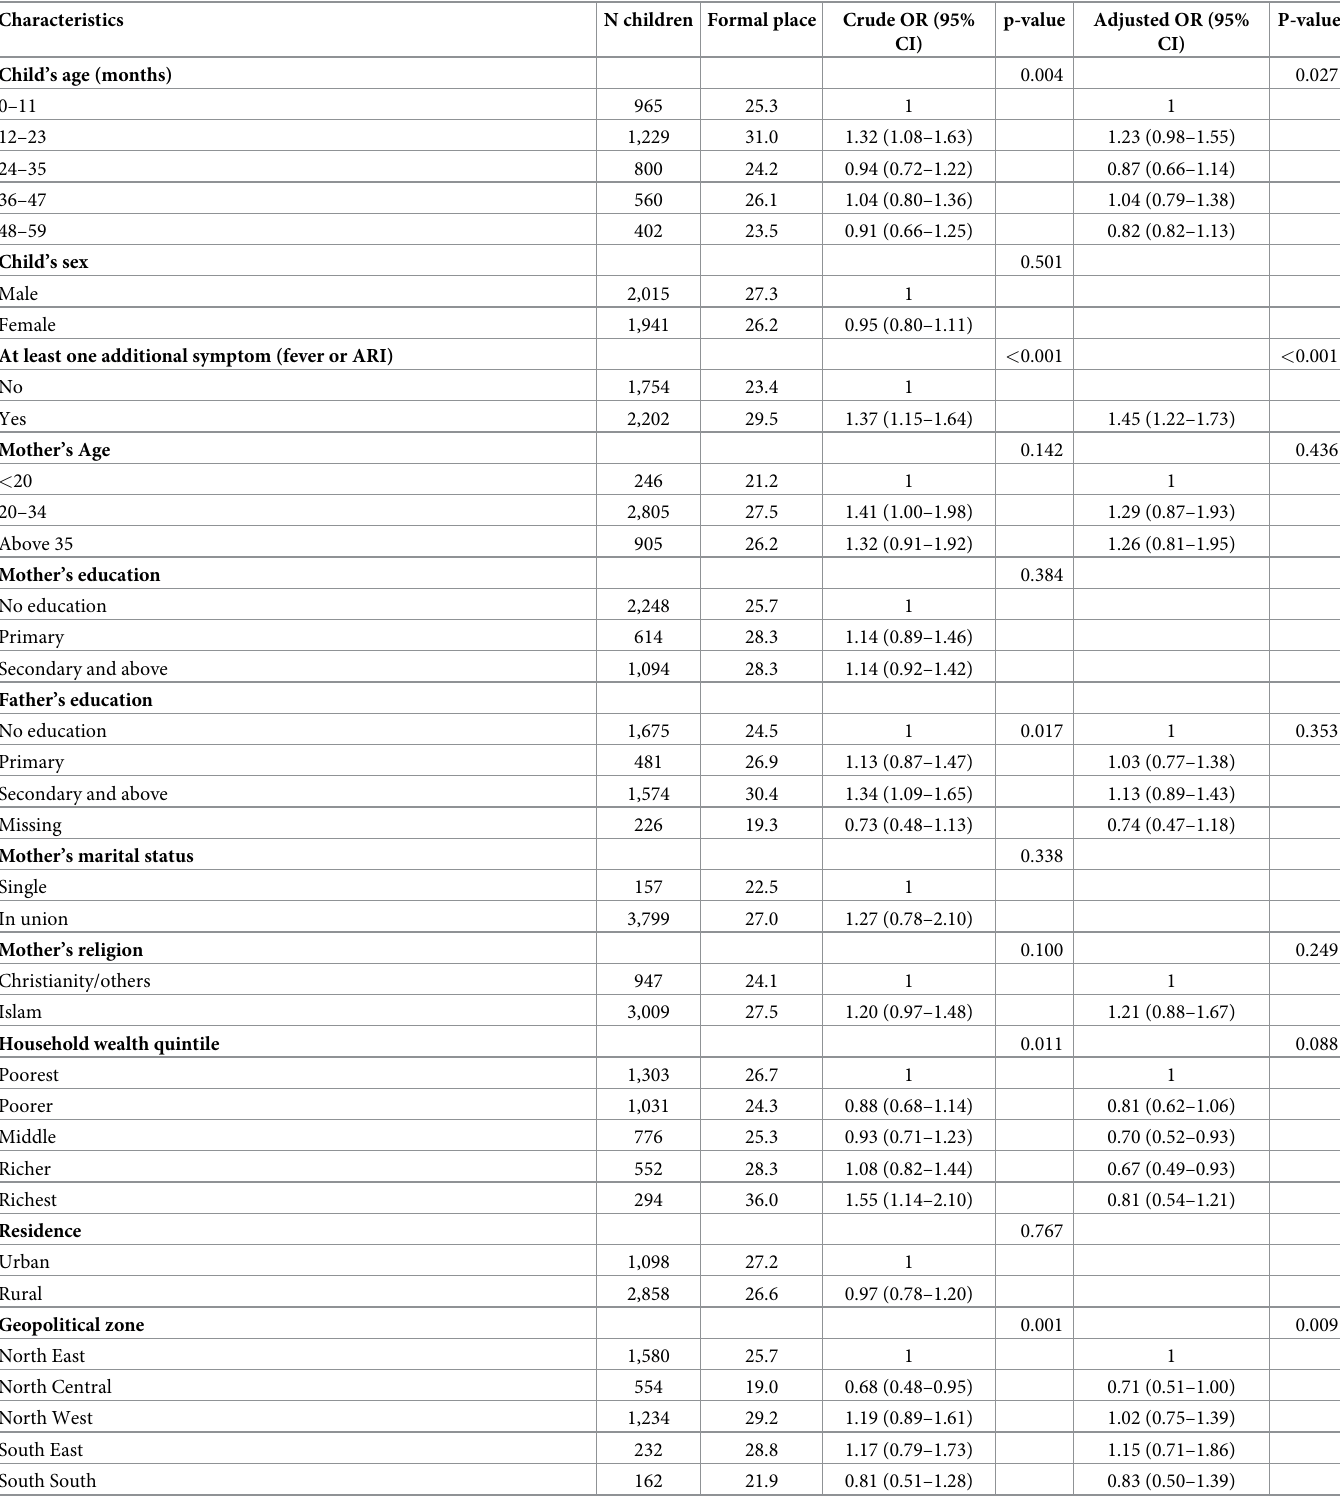
Table 5. Logistic regression analysis of factors associated with seeking care in appropriate place for children under five with diarrhoea (N = 3,956).